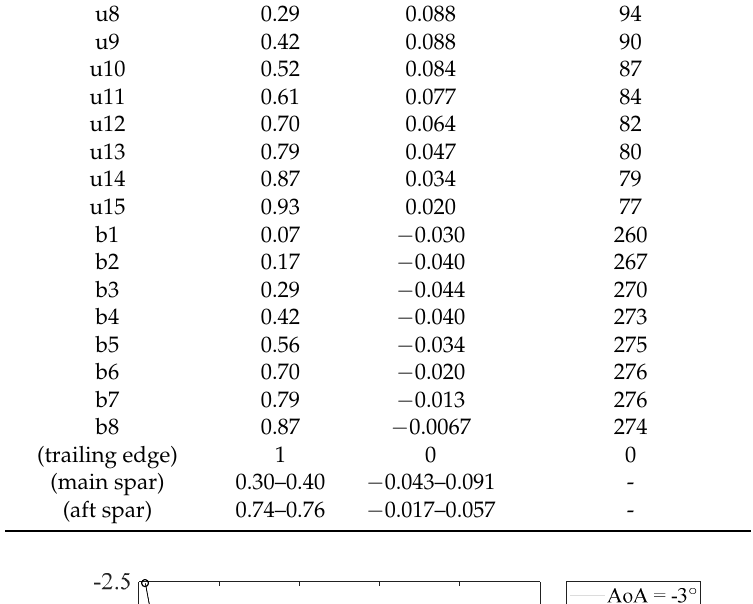
Table 2. Pressure port geometry. C represents chord length.